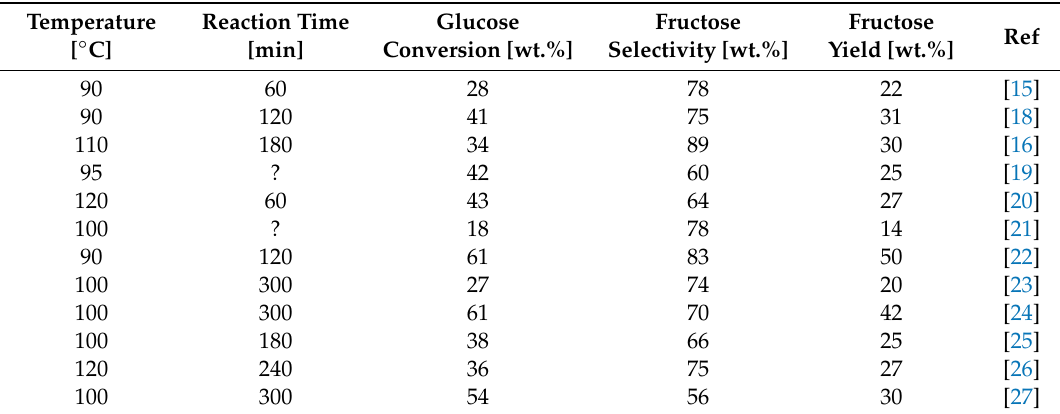
Table 1. Isomerization of glucose to fructose using hydrotalcite